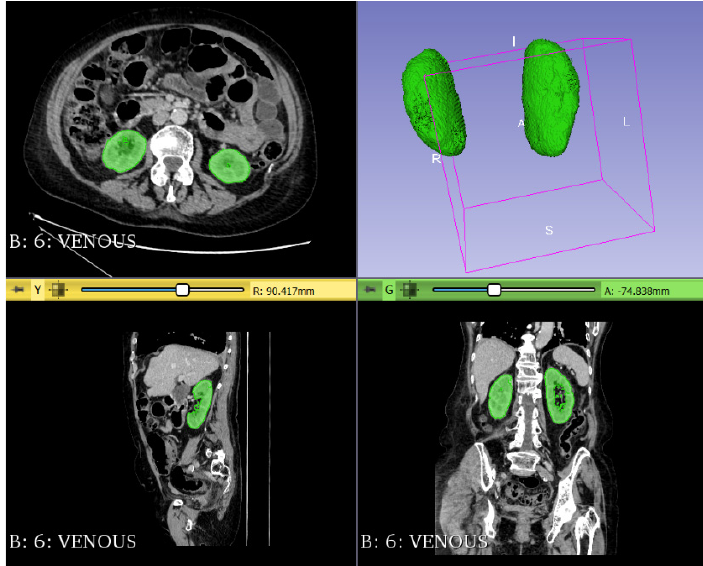
Figure 4. Renal volume measurement.